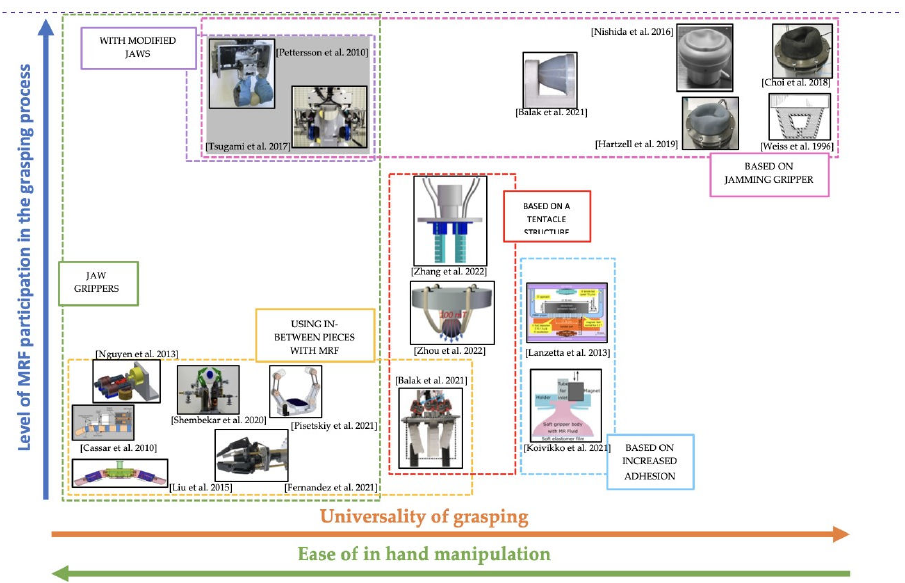
Figure 1. Classification of grippers using MRF, based on [6]. The grey rectangle indicates the area covered by the article. The Grippers’ images are from the following publications